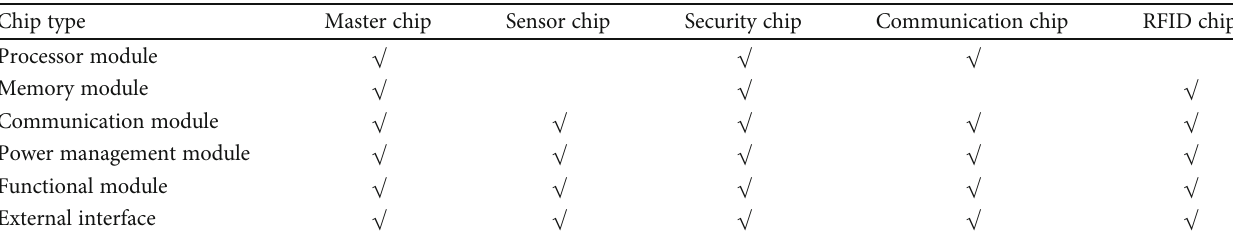
Figure 1: Application and classi fi cation of power chips. Table 1: Traditional power chip architecture